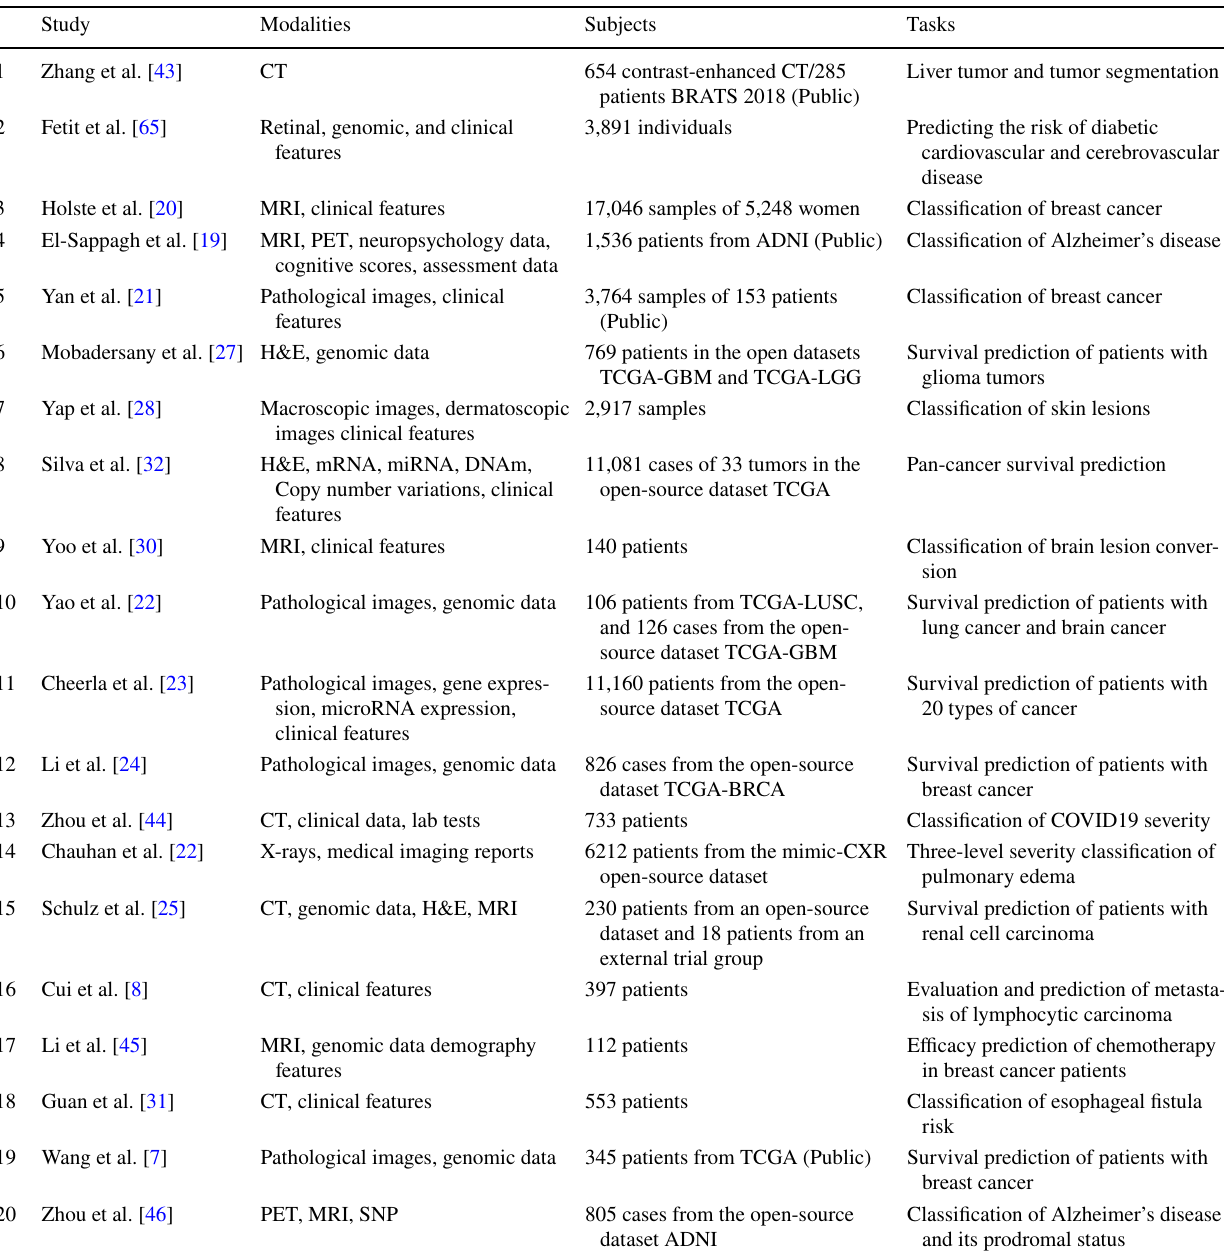
Table 2 Number of objects and tasks studied in medical imaging and non-imaging models